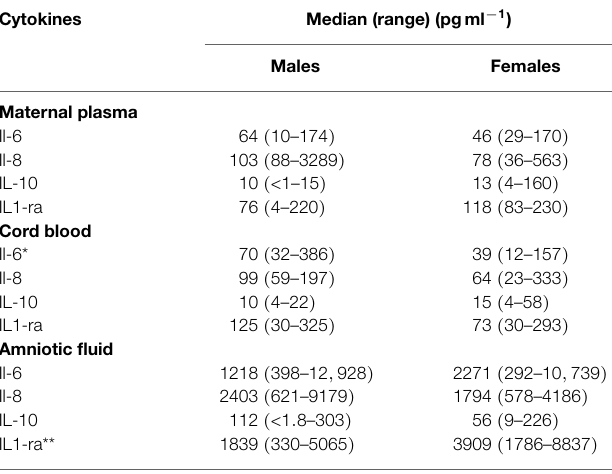
TABLE 3 | Comparison by sex of the infant (males = 12, females = 12) of median cytokine levels in maternal plasma, cord blood, and amniotic fluid obtained during elective cesarean delivery